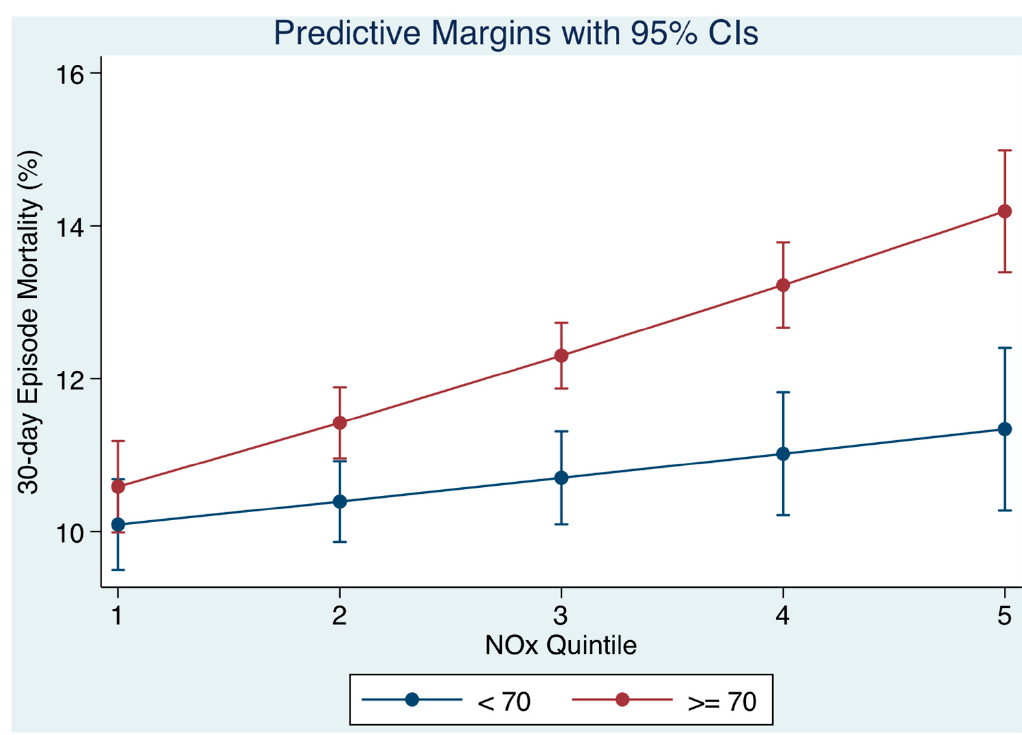
Figure 2. The 30-day in hospital mortality related daily oxides of nitrogen (NO x ) levels by quintiles to the 30-day in-hospital mortality and adjusted for socio-economic status (SES) and other outcome predictors. We used margins to estimate the average marginal effect. As NO x quintiles increased (level of NO x on day of admission), the 30-day mortality progressively increase but was higher for older persons.